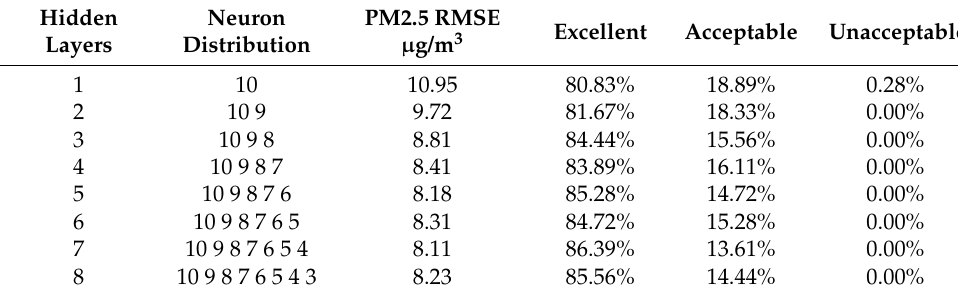
Table 3. PM2.5 prediction results with different hidden layers.